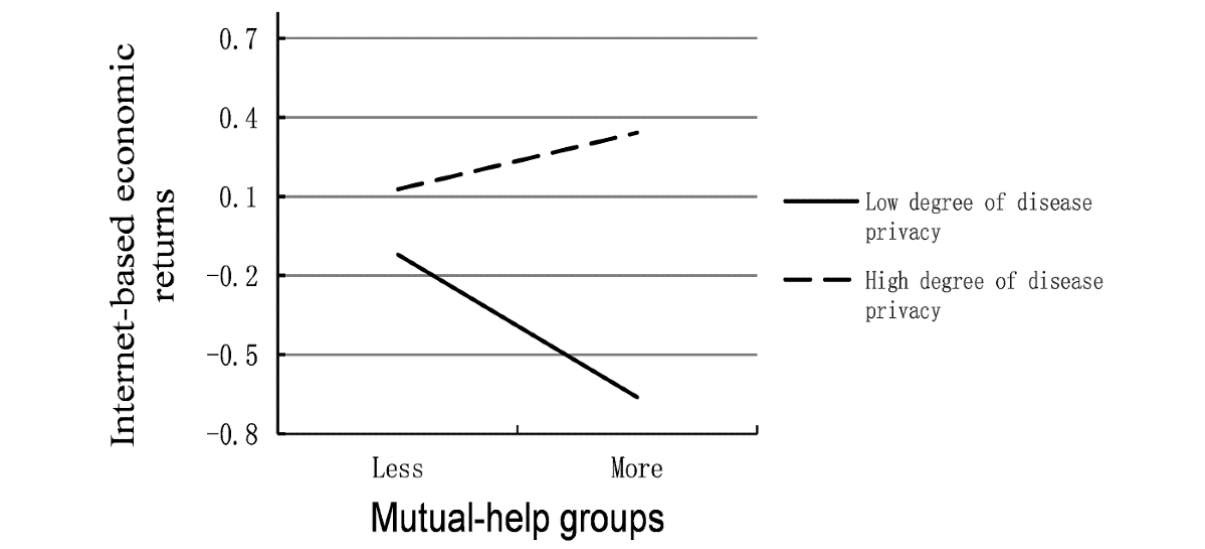
Figure 2. Interaction between mutual-help group and disease